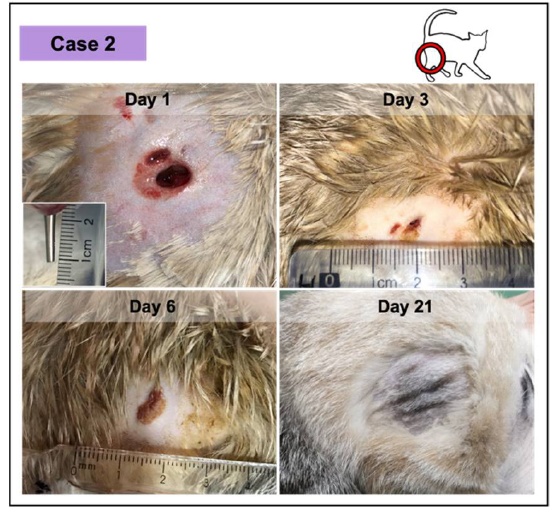
Figure 4. Wound healing evolution of case 2. The wound was infected, resulting from a dog bite (inset photograph demonstrating the depth at day 1). The complete wound healing was achieved at day 11. At day 21 (ten days after), the skin exhibited a normal appearance.